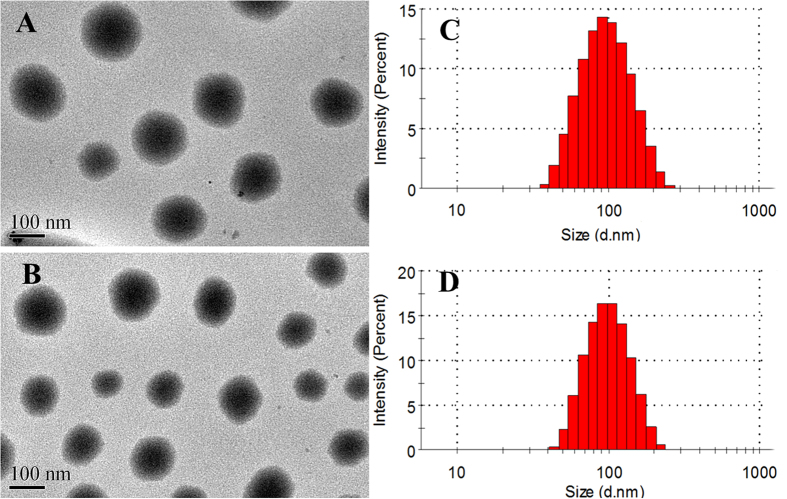
TEM image of NP-PTX (A) and Pep-NP-PTX (B); the size distribution of NP-PTX (C) and Pep-NP-PTX (D).